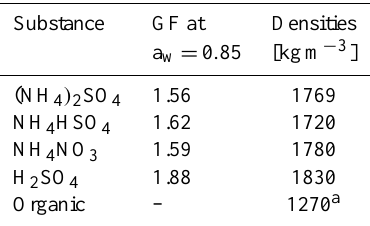
Table 2. GF and density used in the ZSR calculation (Bulk proper- ties; Topping et al., 2005a).